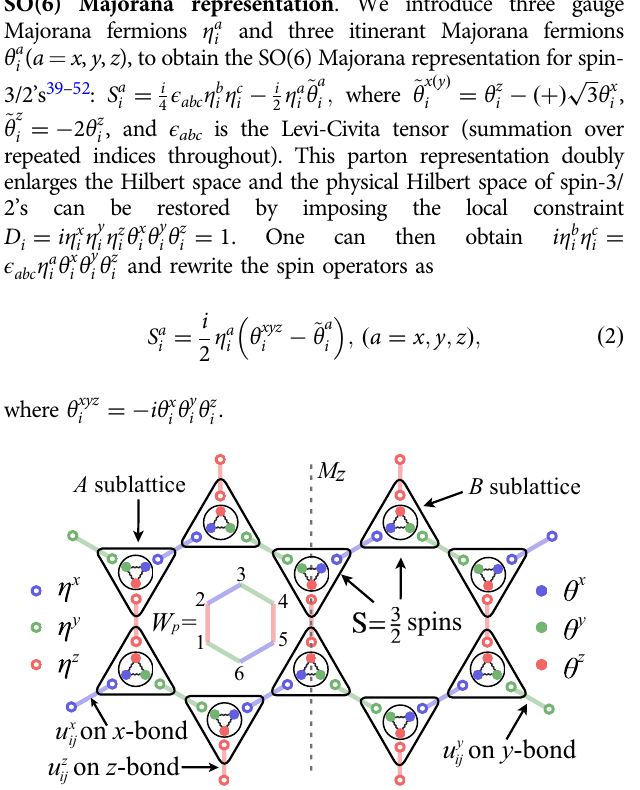
Fig. 1 Graphic representation of the S = 3/2 KHM (3) and the SO(6) Majorana representation. Down (up) triangles stand for S = 3/2 spins on A ( B ) sublattice. Each spin is represented by SO(6) Majoranas, e.g., three gauge Majoranas η x , y , z (circles) and three itinerant Majoranas θ x , y , z (dots). The blue, green, and red bold lines denote the static Z 2 gauge fi elds u x , u y , and u z for x -, y -, and z -bond Ising interactions, respectively. The plaquette operator W p (cid:2) (cid:3) e i π ð S x 1 þ S y 2 þ S z 3 þ S x 4 þ S y 5 þ S z 6 Þ can be expressed as the product of u a p . The gray dashed line stands for the mirror symmetry ij around hexagon M J = J z with x y